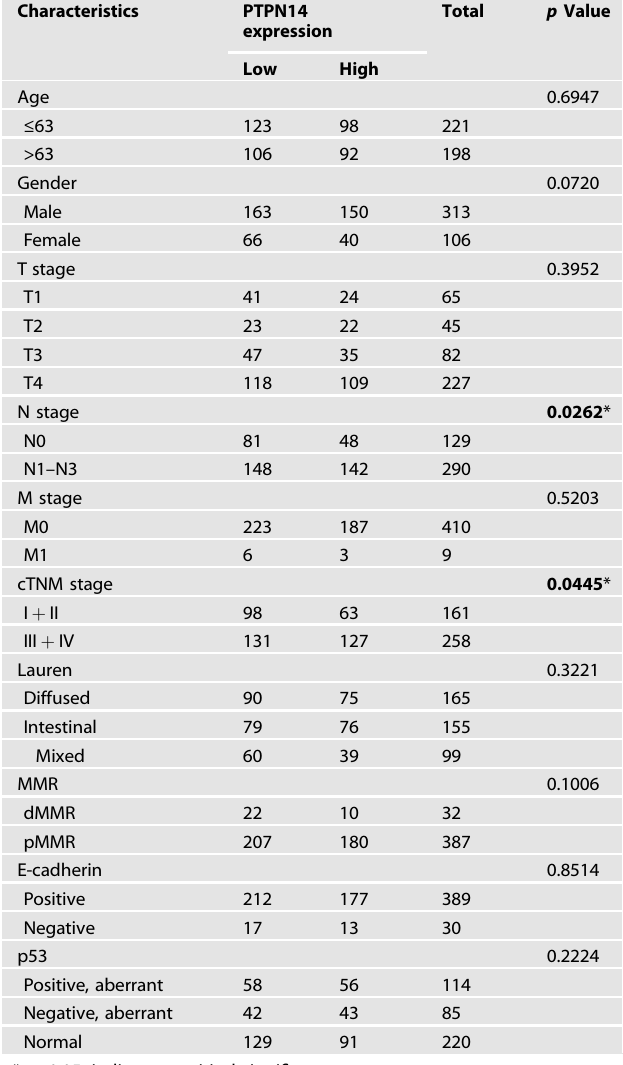
Table 1. PTPN14 expression and correlation with clinicopathological patient